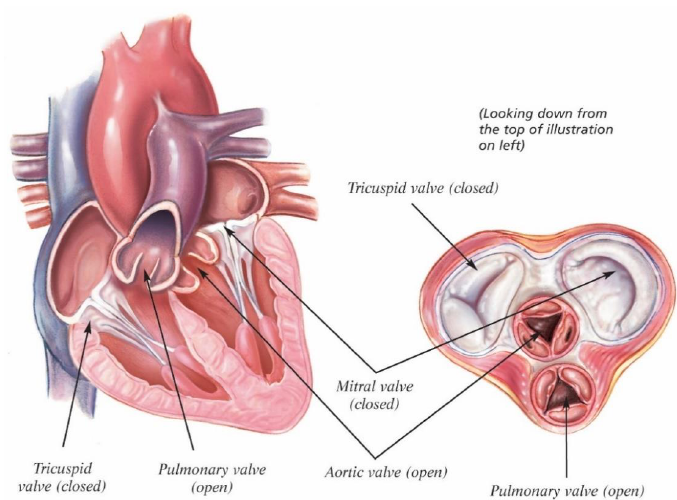
Figure 2. A schematic view of the heart valves. Reprinted with permission from ref. [62]. Copyright 2022, Edwards Lifesciences Corporation.